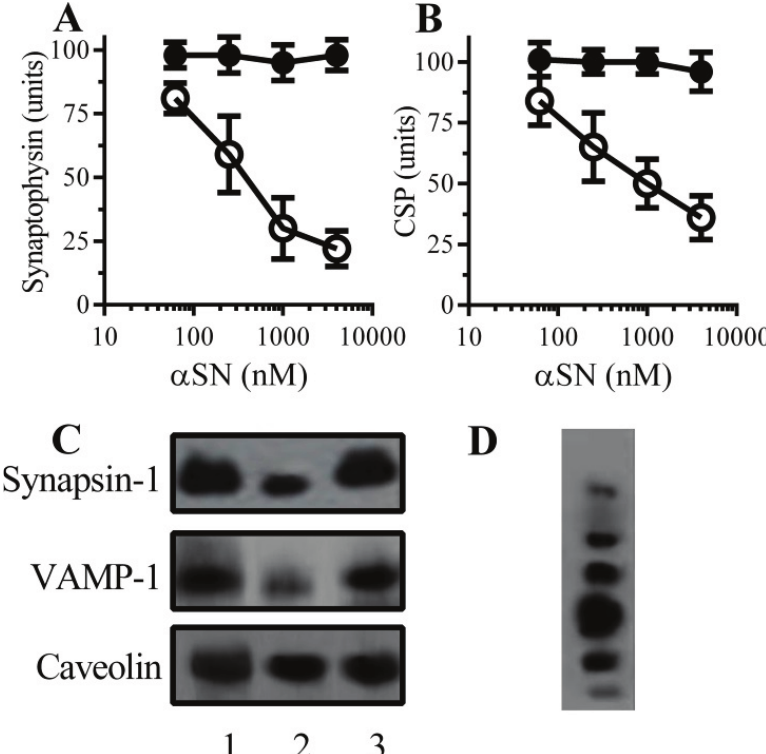
Figure 1. (cid:2)-synuclein ((cid:2)SN) triggered the loss of synaptic proteins from neurons—The amounts of synaptophysin ( A ) and cysteine string protein (CSP) ( B ) in neurons incubated with (cid:2)SN ((cid:4)) or (cid:3)SN ((cid:5)) as shown. Values are means ± SD from triplicate experiments performed three times, n = 9; ( C ) Immunoblots showing the amounts of synapsin-1, vesicle-associated membrane protein (VAMP)-1 and caveolin in neurons incubated with control medium (1), 1 μM (cid:2)SN (2), 1 μM (cid:3)SN (3); ( D ) Immunoblot showing aggregates of recombinant human (cid:2)SN separated by non-denaturing polyacrylamide gel electrophoresis